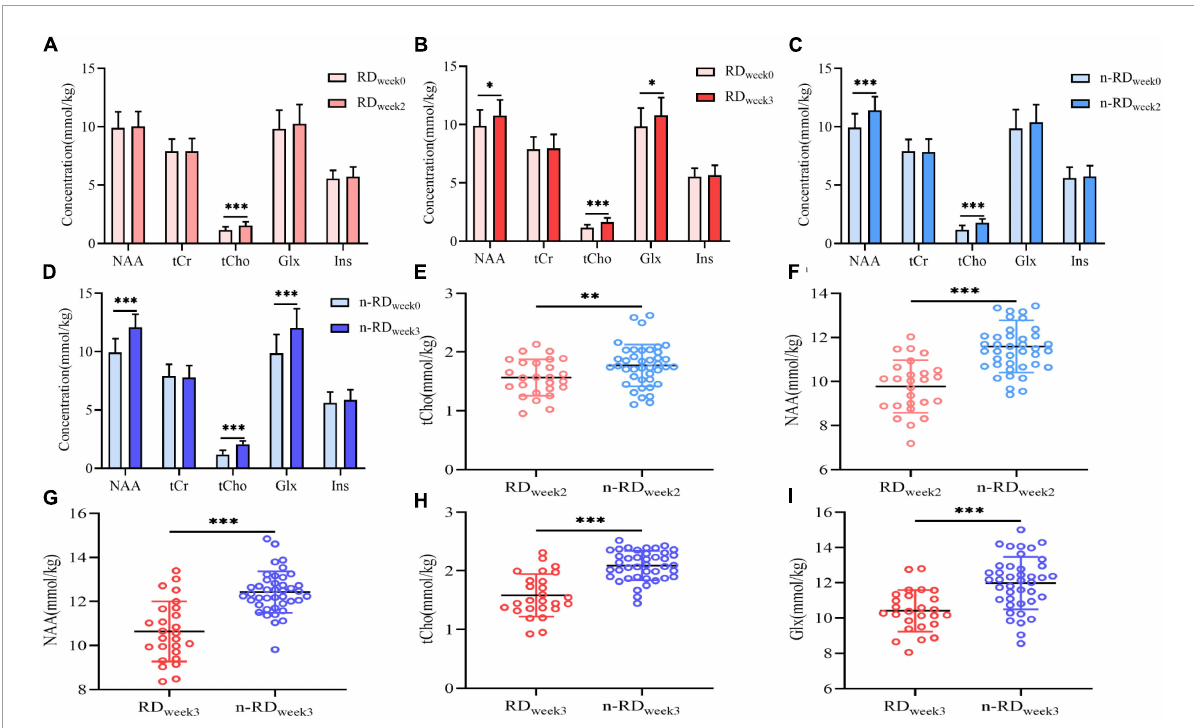
FIGURE4 (A–D) The within-group comparisons of longitudinal metabolic change in refractory depression group and non-refractory depression group show significant differences after 2 and 3 weeks of treatment. (E–I) The between-group comparisons of metabolic change in refractory depression group and non-refractory depression group show significant differences after 2 and 3 weeks of treatment. NAA, N-acetyl-aspartate; tCho, phosphocholine and glycerophosphocholine; tCr, creatine and phosphocreatine; Glx, glutamate and glutamine; Ins, myo-inositol; * p < 0.05, ** p < 0.01, *** p <